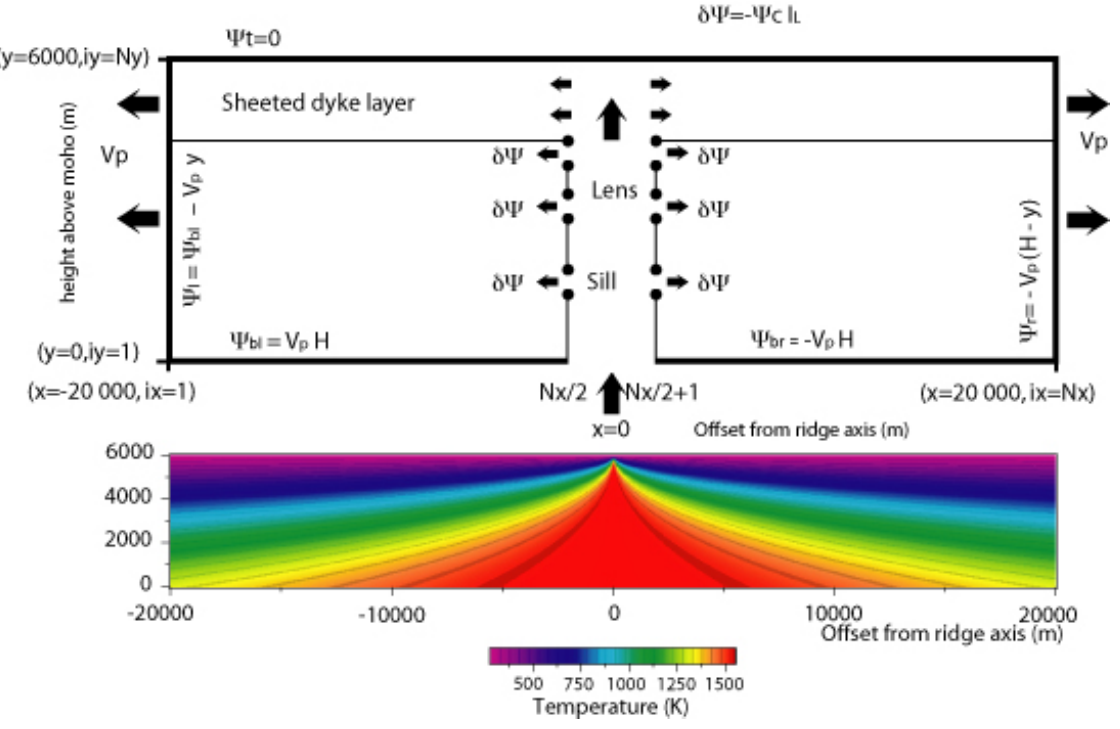
Fig. 1. Sketch of the stream-function (top) and temperature (bottom) internal and boundary conditions. The computation grid is composed of N x vertical columns (from 1 to N x , x = − L to x = L ) and N y rows (from 1 to N y , y =0 to y = H ). The ridge axis is located between the points N x / 2 and ( N x / 2)+1 where the amplitude of the stream-function jump is equal to 9 c = 2 V p H , the total flux of crust that leaves the computation box through the left and right lateral boundaries. At the top of the crust and at the Moho level, 9 is constant (impervious boundary), except at the ridge axis. Its bottom left value has been set to 9 bl = V p H . Internal stream function jumps, δ9 , on the two central columns, drive the melt intrusion through sills and/or lenses. Initial and internal boundary conditions are also applied to the temperature field according to a half-space lithospheric cooling law (Eq. 14).